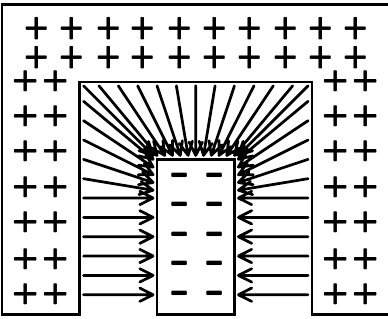
Figure 4. Schematic diagram of electric field distribution at different positions of